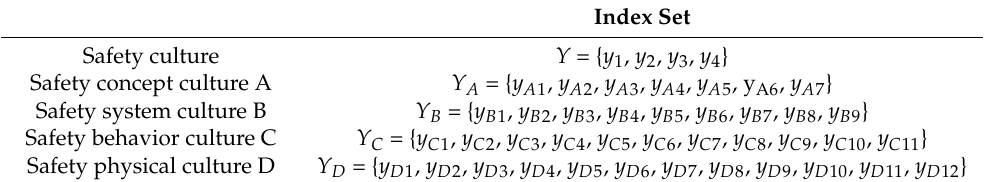
Table 4. Corresponding Table of Each Indicator Set.